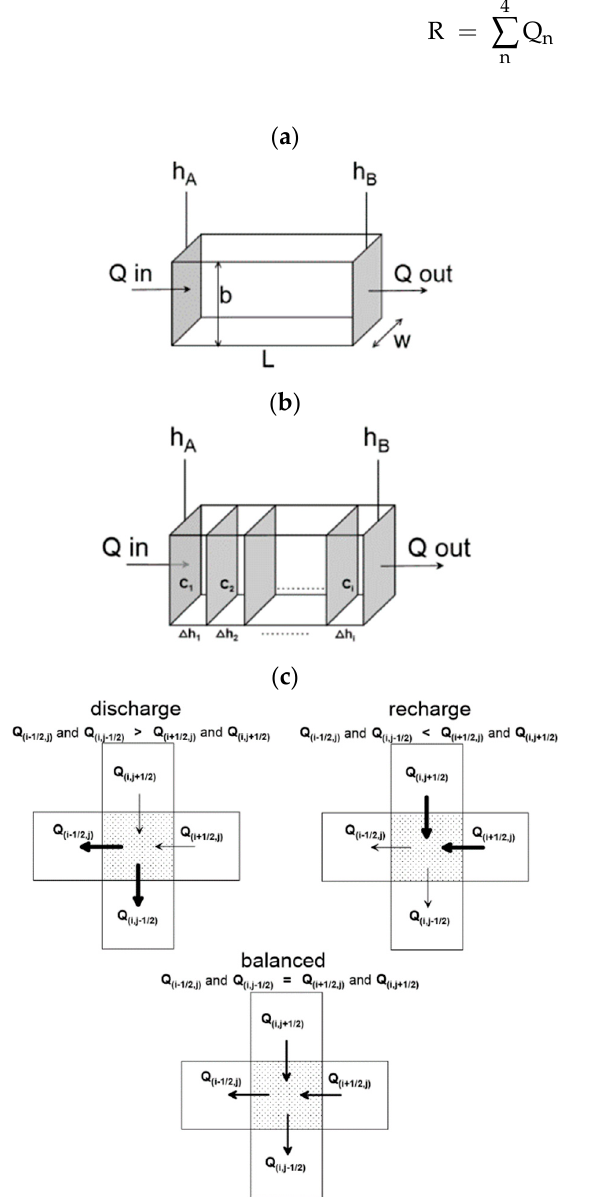
Figure 4. ( a ) Groundwater flow cell with length L, width w, and height b, showing one dimensional flow Q (length 3 /time) in response to hydraulic head loss from h A to h B . ( b ) A group of adjacent cells with conductance C i and an incremental change in hydraulic head ∆ h i (adapted from Harbaugh, 2005). ( c ) Example of groundwater recharge, discharge, and balanced cells (shaded) in a two-dimensional volume balance residual raster, where conductance is homogeneous, h(i + 1,j) and h(i,j + 1) > h(i,j), and h(i − 1,j) and h(i,j − 1) < h(i,j). The bolder arrows represent greater flow magnitude.